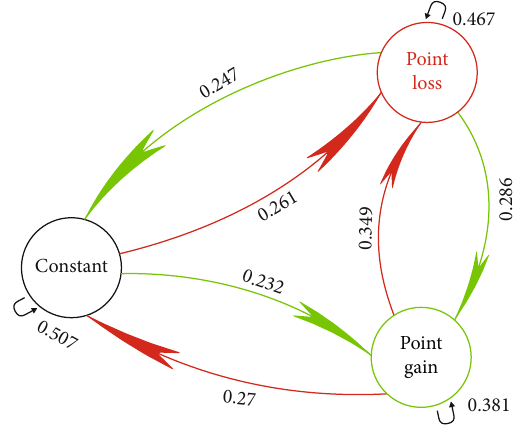
Figure 4: Cal Bank equity transition matrix and diagram.